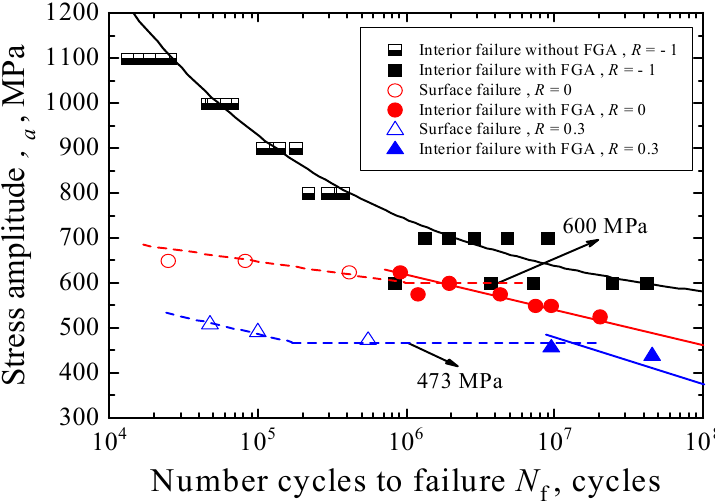
Figure 5. S–N curve of carburized Cr-Ni gear steel.